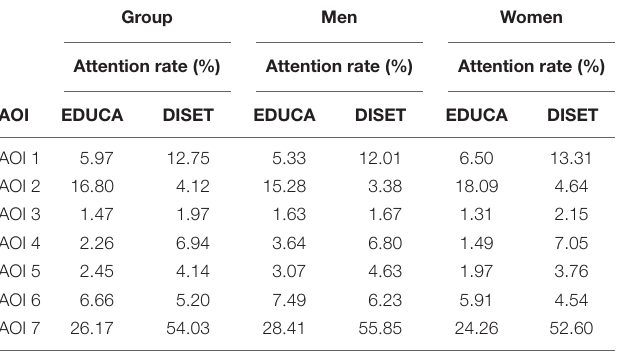
TABLE 3 | Attention percentage of the total number of participants to each AOI. Group Men Women Attention rate (%) Attention rate (%) Attention rate (%)